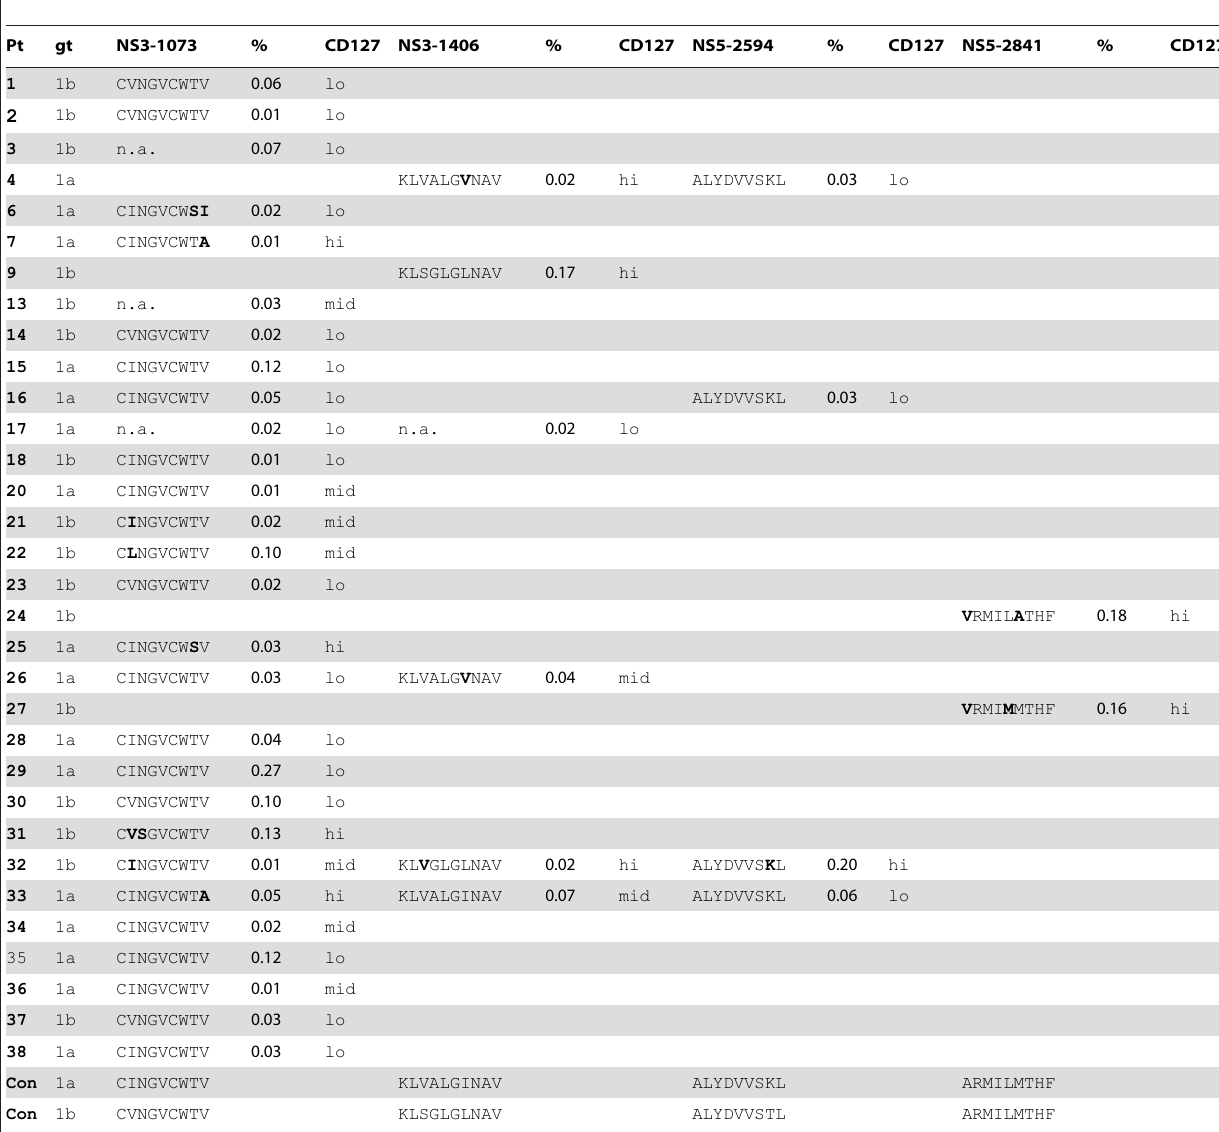
Table 2. Epitope sequence analysis and correlation with CD127